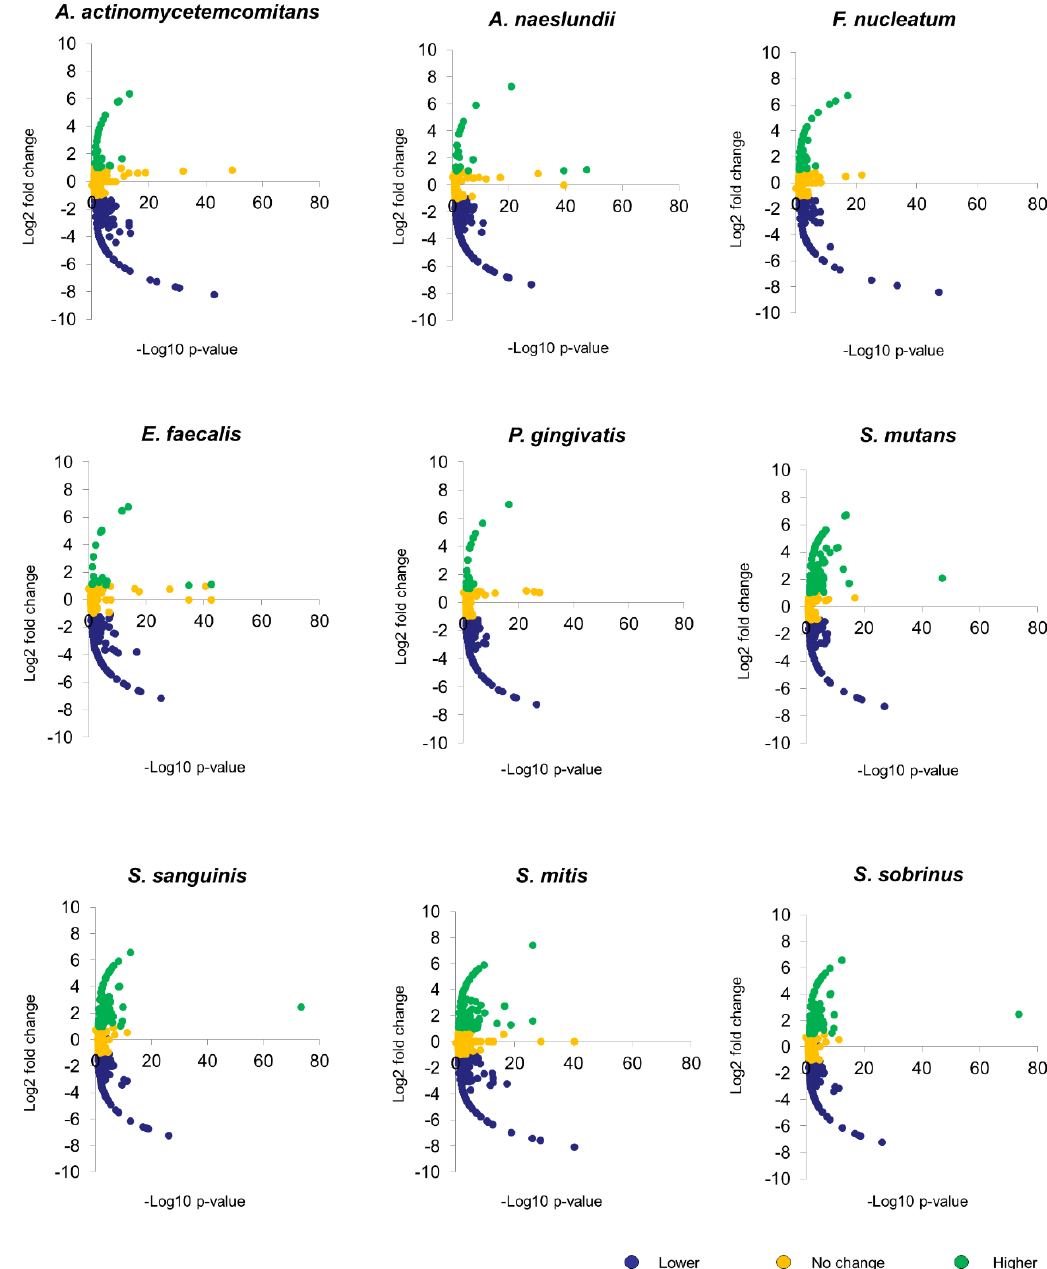
Figure 1. Volcano plots of protein expression changes of C. albicans biofilms. Biofilm development of C. albicans SC5314 was conducted at 37 °C. The 48 h mature biofilms were treated with 10 8 heat-killed bacteria for 2 h at 37 °C. Proteins were then extracted and sent for label free mass spectrometry analysis. Volcano plots illustrated significance versus fold changes of different proteins expressed in C. albicans biofilms under stimulations of A. actinomycetemcomitans, A. naeslundii, F. nucleatum, E.